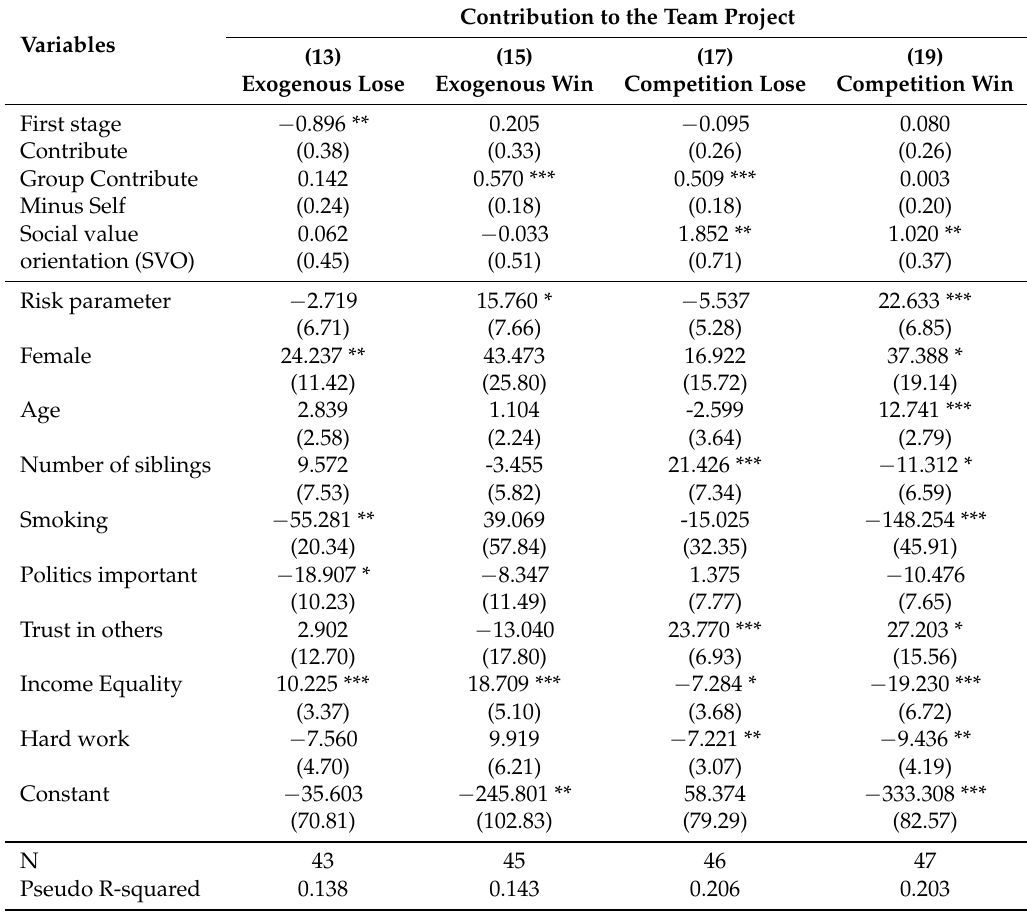
Table A6. Effect of first stage contribution and dummies on cooperation level in the team project.